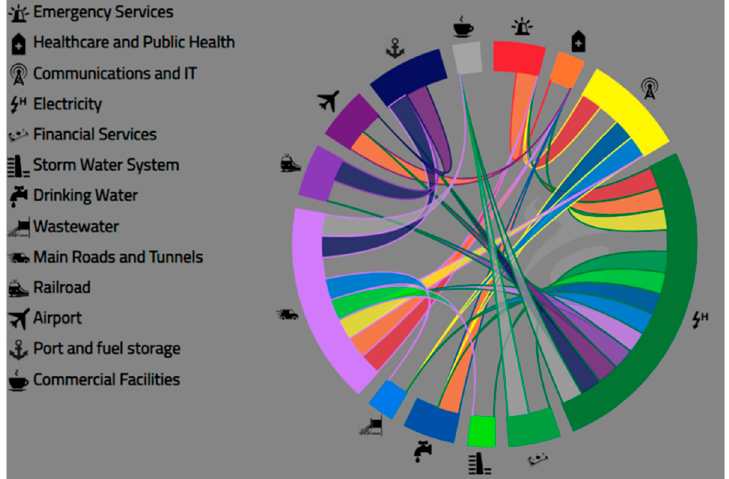
Figure 5. Illustration of the critical infrastructure (CI) dependencies in a CIrcle diagram.